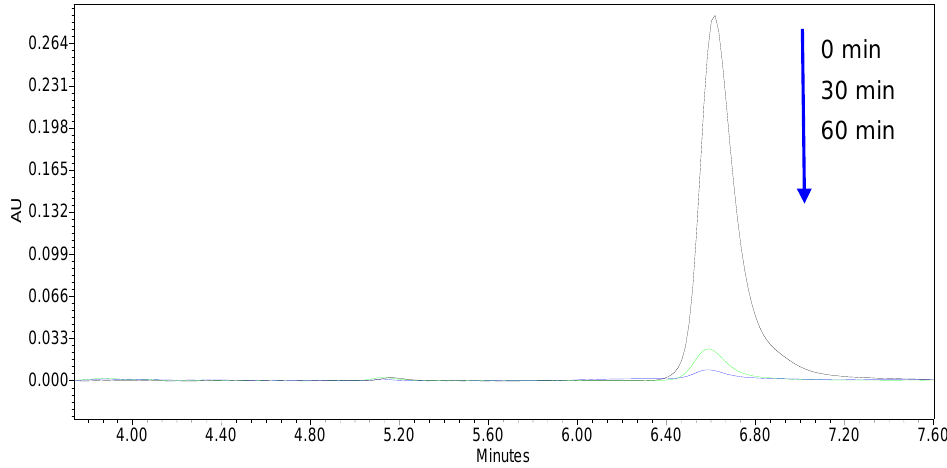
Figure 8. Time-dependent chromatogram of the measured HPLC peak for CA obtained for the samples collected with different reaction durations using the E-750 catalyst.